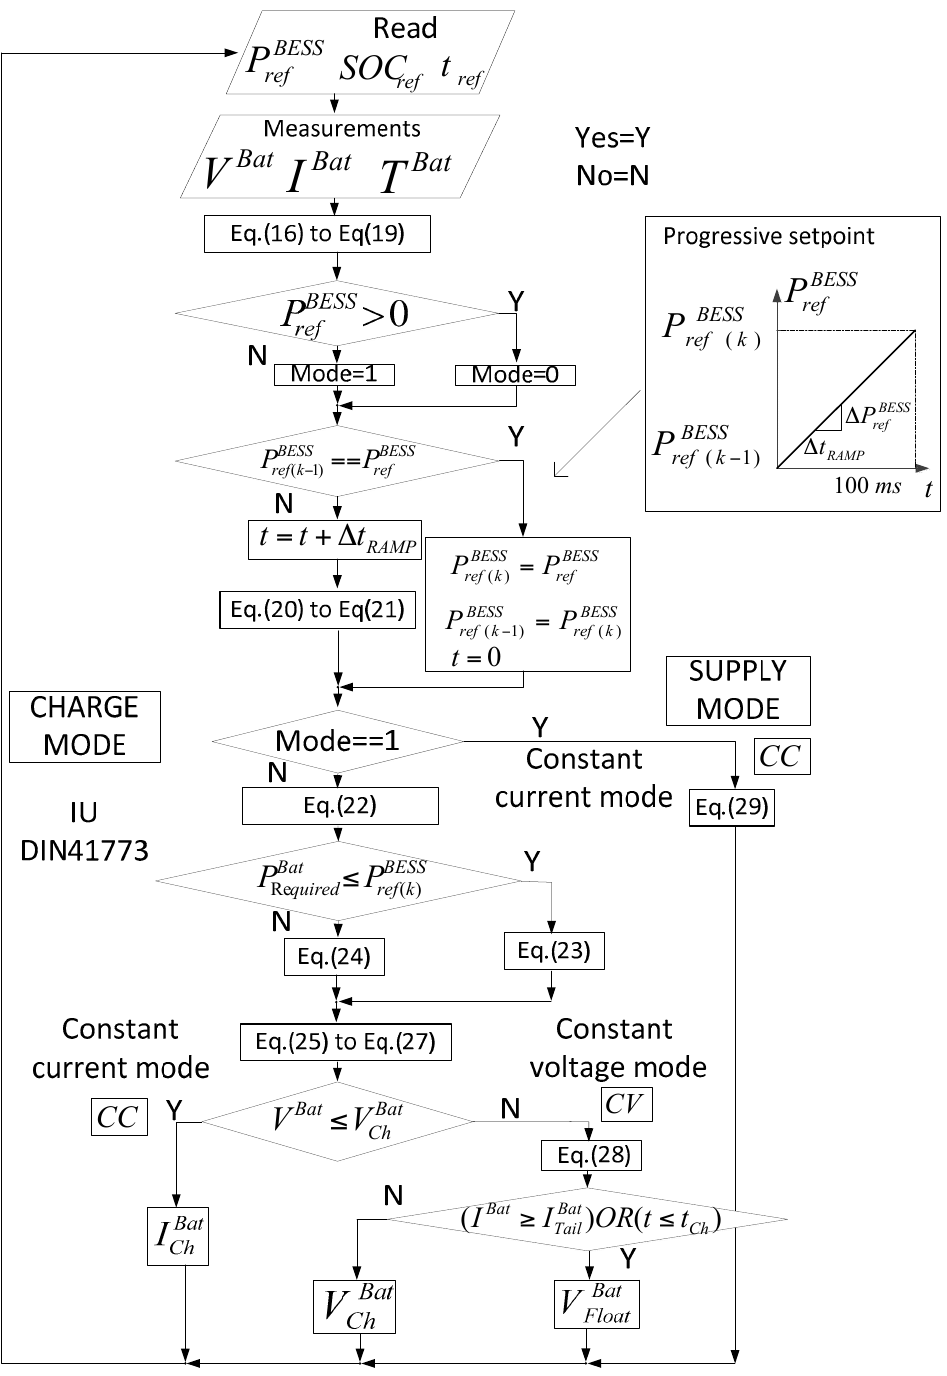
Figure 8. Battery charging algorithm.